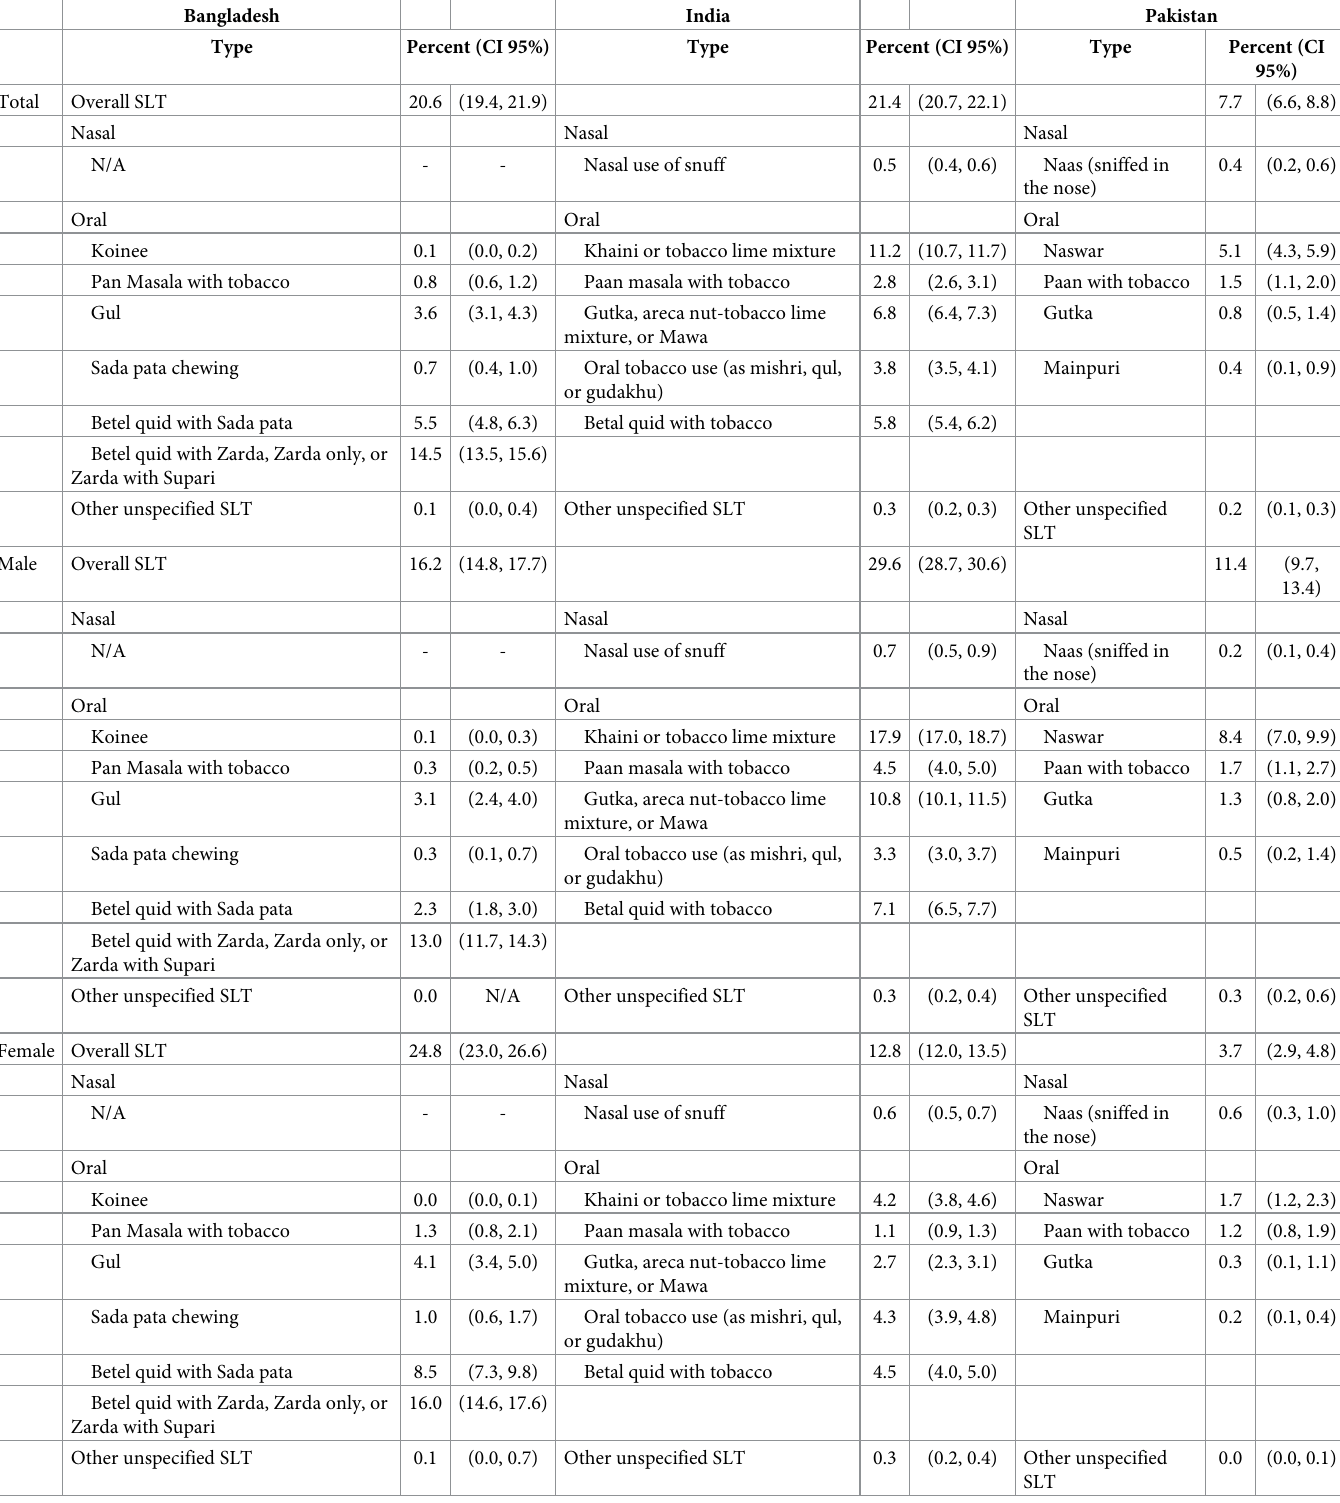
Table 2. Prevalence of current smokeless tobacco use overall and by type among adults aged 15+ by in Bangladesh, India and Pakistan, GATS 2014–2017. Bangladesh